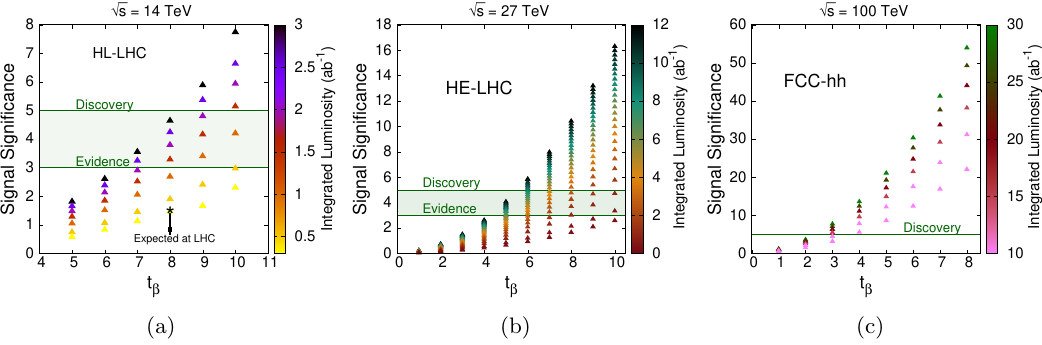
Figure 9 . Signal signi(cid:12)cance as a function of t scenario: (a) SA , (b) SB and (c) SC